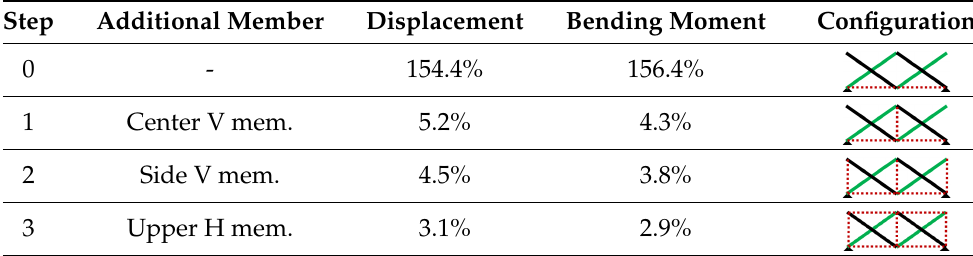
Table 2. Optimal reinforcing procedure for two scissors unit